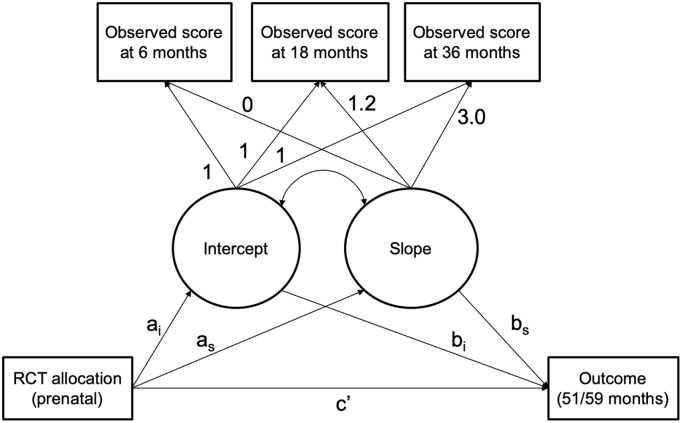
Schematic representation of the hypothesized mediation model.Treatment allocation is a binary variable representing the treatment (coded 1) and control (coded 0) groups. Loadings for the intercept factor were fixed to 1; the first loading for the slope factor was fixed to zero, and the following to 1.2 and 3.6 respecting the laps of time between the observations. The estimated parameter ai and as represent the effect of the treatment on the initial point (intercept, i.e., 6 months) and on the linear rate of change (i.e., increasing or decreasing) over time of the modeled mediator. The parameters bi and bs represent the effect of the mediator (both intercept and growth factors) on the child outcomes. The estimated parameter ‘c’ represents the direct association, i.e., the remaining non-mediated effect. Estimated residual variances for the observed scores are omitted from the figure for clarity.